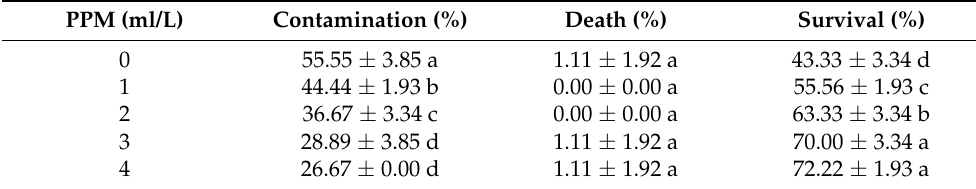
Table 2. Effect of PPM on explant sterilization.